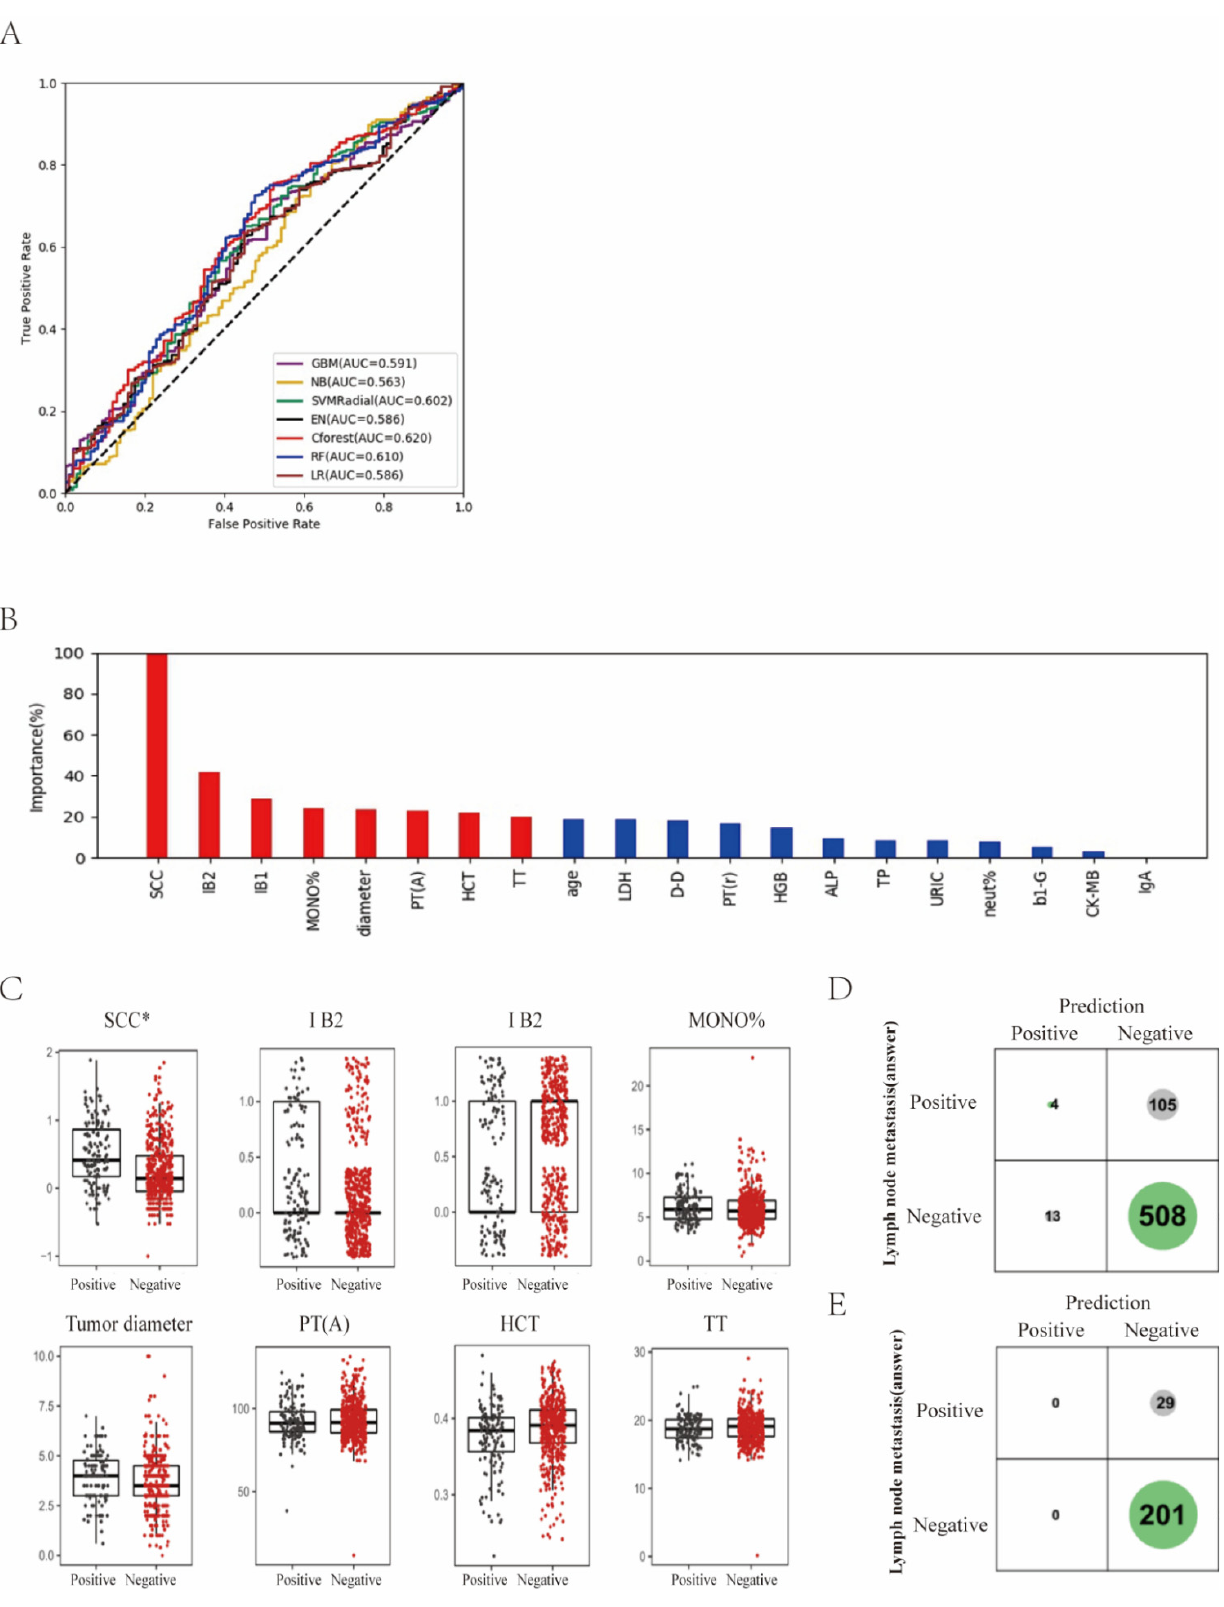
Figure 2. Differentiation of lymph node metastasis of cervical cancer with machine learning methods. ( A ) ROC curves derived from logistic regression for predicting lymph node metastasis of cervical cancer based on all 75 peripheral blood markers using machine learning methods compared with logistic regression. ( B ) Relative importance of variables for prediction of lymph node metasta- sis calculated in the Cforest. Variable importance is represented as a percentage of the highest value.